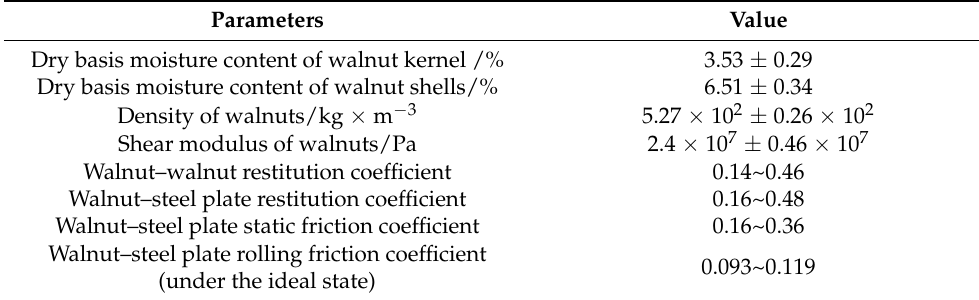
Table 1. Parameter lists of the Physical test measurement results.